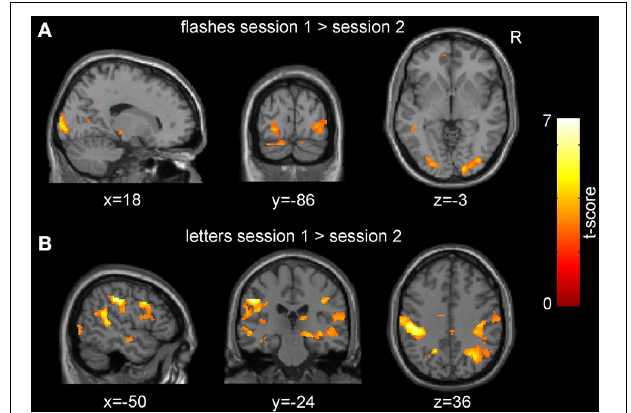
FIGURE 2 | Group-level main effects across both sessions. (A) The presentation of the pattern flashes resulted in a significant activation in the occipital cortices. The dashed blue lines indicate the borders of the acquired field of view. (B) The presentation of the letters and subsequent responses resulted in an activation of several clusters including the somatosensory cortices ( p < 0 . 05, FWE corrected for multiple comparisons at the voxel level).